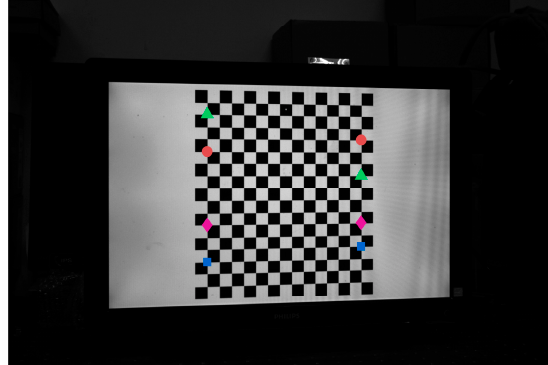
Figure 14. Marker points.